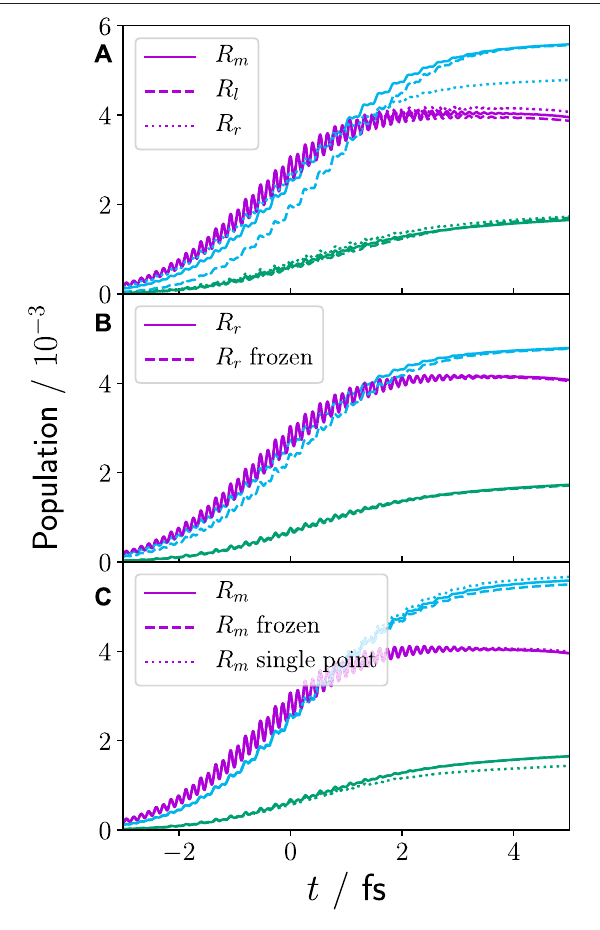
FIGURE 3 | Population, a 1e n ( t ) , of the fi rst three parent ion states, φ 1e ( y ; R ) ( n = 0 (violet), n = 1 (green), n = 2 (blue)), during the XUV ionisation, n Eq. 23 . Panel (A) shows the comparison of equilibrium (solid lines), i.e., zero nuclear and electron momentum at time of ionisation, and non- equilibrium con fi guration (dashed/dotted lines), i.e., R l / R r : positive/negative nuclear and electron momentum at time of ionisation. (B) comparison of R r and frozen nucleus R r , i.e., no quantum mechanical nuclear degree-of- freedom but sampled nuclear wave packet (see Subsection 2.1.2 ). (C) comparison of R m , frozen nucleus R m , and a single 2D purely electronic calculation with a point charge central nucleus at R 0, m .